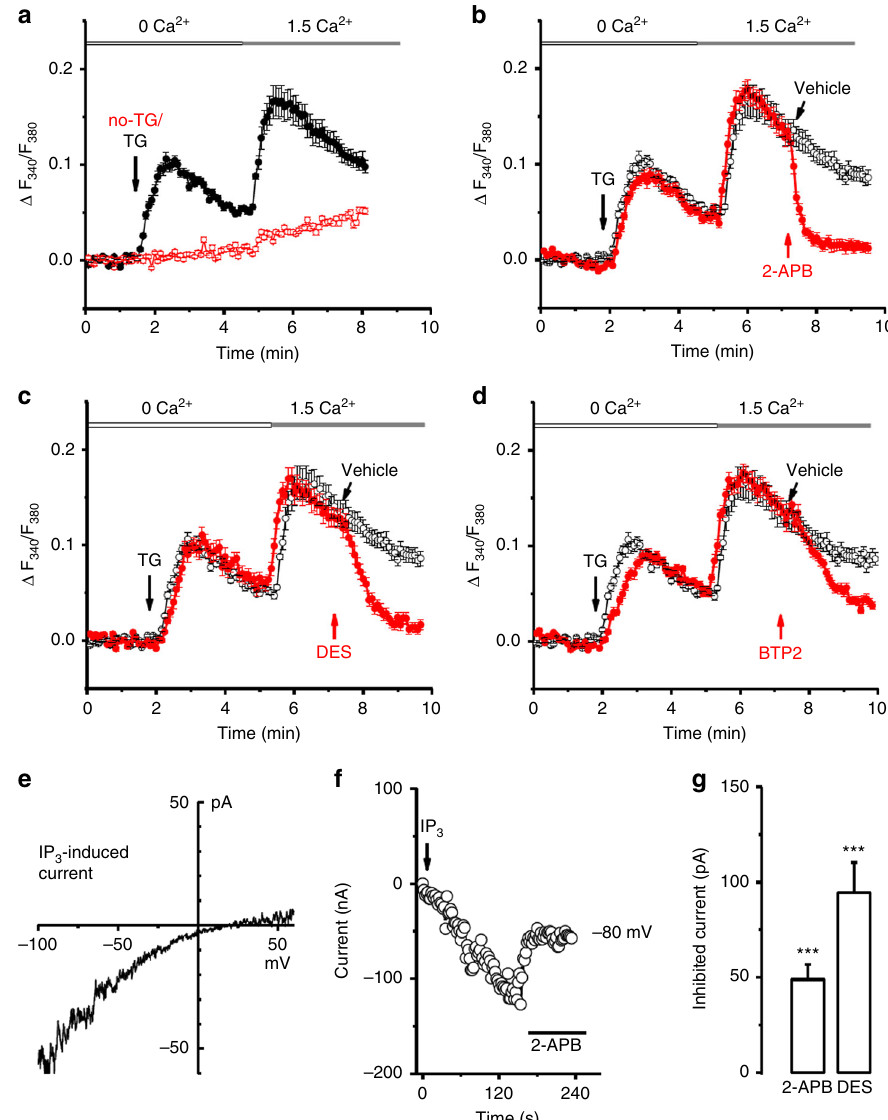
Fig. 2 Store-operated Ca 2+ entry and Ca 2+ release-activated current ( I CRAC ) in proximal tubular epithelial HK-2 cells. a Store-operated Ca 2+ in fl ux induced by thapsigargin (TG, 1 µ M, n = 12) compared to the group without TG (no-TG, n = 13). b 2-APB (100 µ M, n = 14 cells) or vehicle (0.1% dimethyl sulfoxide (DMSO); n = 13 cells) was applied after store-depletion by TG and during perfusion with bath solution containing 1.5 mM Ca 2+ . c Diethylstilbestrol (DES; 10 µ M, n = 15 cells) or vehicle (DMSO, n = 13 cells) was applied as in ( b ). d Perfusion with BTP2 (1 µ M, n = 17 cells) or vehicle (DMSO, n = 13 cells) as in ( b ). e Current – voltage ( IV ) relationship for I CRAC induced by IP 3 (30 µ M) in the pipette solution. f Time course for I CRAC induced by IP 3 and the inhibition by 2-APB (100 µ M) in HK-2 cells. g Mean ± s.e.m. data for I CRAC inhibited by 2-APB (100 μ M, n = 8) and DES (10 µ M, n = 5). *** P < 0.001. The data sets are compared by t test. Statistical signi fi cance is indicated by *** P < isoforms in proximal tubular epithelial cells (PTECs) using They were preferentially localized to kidney tubules, with stronger human cell models and biopsies, in vivo diabetic mouse models staining in the proximal tubules than in the distal convoluted and transgenic mice. ORAI channels act as key elements in the tubules (Supplementary Fig. 1c). This is in agreement with rat endocytic process of albumin reabsorption in PTECs. Down- RNAseq data showing higher tubular than glomerular expression regulation and enhanced internalization of ORAI channel com- of all ORAI1-3 genes 10 and also with available human RNAseq plexes with the endocytic receptors during albuminuria could data (Nephroseq) for ORAI2 expression in human kidney sam- account for the progressive deterioration of renal function in ples from healthy living donors, con fi rming higher tubular than patients with DN. glomerular expression of this gene (Supplementary Fig. 2a). ORAI1-3 immunostaining in both proximal tubules and distal tubules was weaker in kidney tissue sections from type 1 diabetic Results patients with DN when compared to non-diabetic controls ORAIs are expressed in human kidney and downregulated in (Fig. 1a – c; Supplementary Table 1 for patient characteristics). DN . ORAI1-3 channels were detected in human kidney samples Correspondingly, human RNAseq data from DN patients with both at the mRNA and protein levels (Supplementary Fig. 1a, b). estimated glomerular fi ltration rate (eGFR) ranging between 12